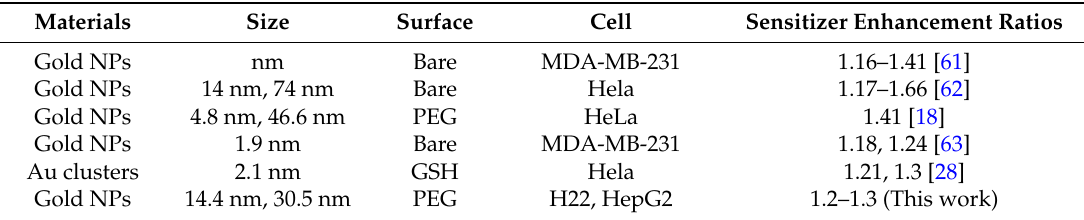
Table 1. Summary of the enhanced cancer radiation of gold